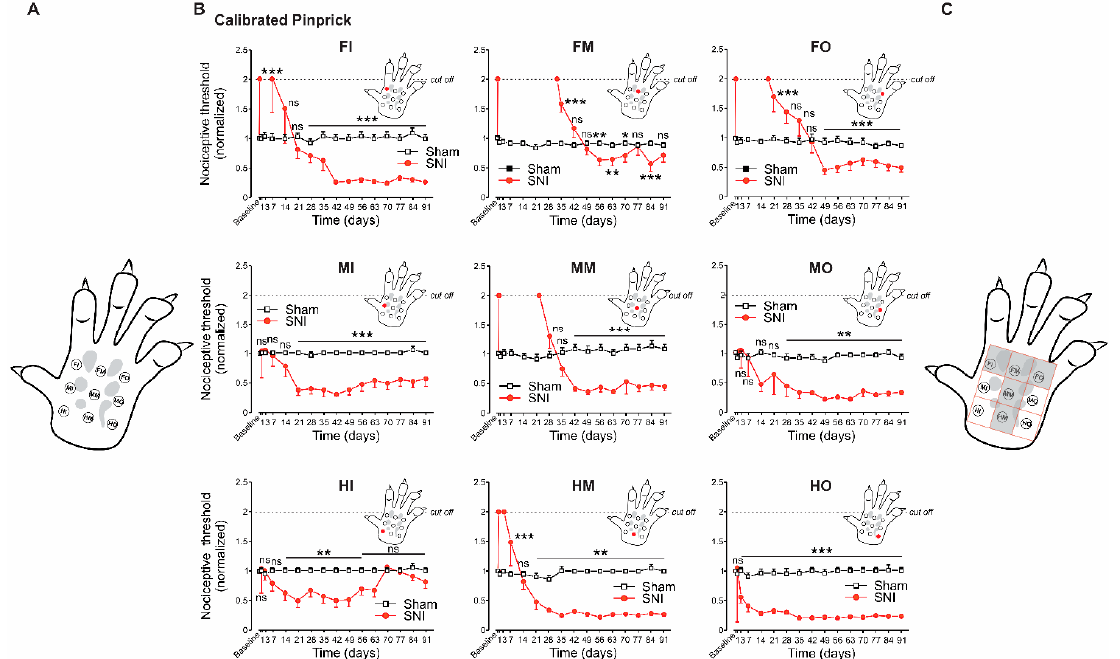
Figure 2. Mapping of the paw reveals di ff erences in the time kinetics of denervation, reinnervation, and development of mechanical hyperalgesia following spared nerve injury (SNI). ( A ) Scheme of the paw depicting the nine subareas, in which nociceptive mechanical threshold was obtained, using calibrated pinprick (see Materials and Methods). The examined areas are proximal medial (HeelIn, HI), proximal middle (HeelM, HM) and proximal lateral (HeelOut, HO); median medial (MIn, MI), median middle (MM) and median lateral (MOut, MO); distal medial (FingersIn, FI), distal middle (FingersM, FM) and distal lateral (FingersOut, FO). ( B ) Changes in the nociceptive threshold measured using calibrated pinprick at the indicated time points after SNI ( red circles ) and sham surgery (white squares) at each of the examined areas (shown in A ). Each subpanel demonstrates the changes in the nociceptive threshold measured in one of the subareas shown in A. The subpanels are organized and labeled according to the examined area (abbreviations and a red dot on the inset). *** p < 0.001; ** p < 0.01; * p < 0.05; ns—not significant, n = 6 rats in each group, RM two-way ANOVA). The baseline value represents the mean value of the three tests performed at three consecutive days before SNI or sham surgery. All of the values were normalized to the baseline value. If animals did not respond to the stimulus higher than 2 × baseline value (120 gr, cut o ff ), the area was considered to be denervated. Note that some areas became denervated after SNI, and all areas developed pain hypersensitivity. Note also that the duration of denervation and the onset of pain hypersensitivity vary among the nine areas. ( C ) Schematic representation of denervated areas after SNI. Note, the T-shaped areas which include the middle part of the paw as well as the distal areas closed to the